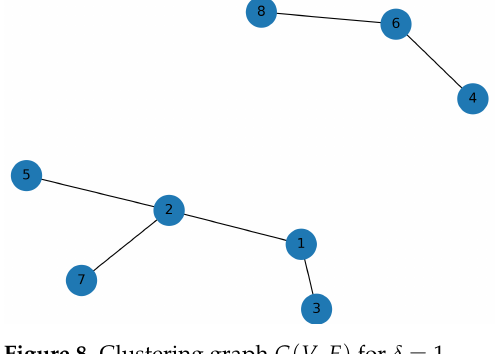
Figure 8. Clustering graph G ( V , E ) for δ = 1.